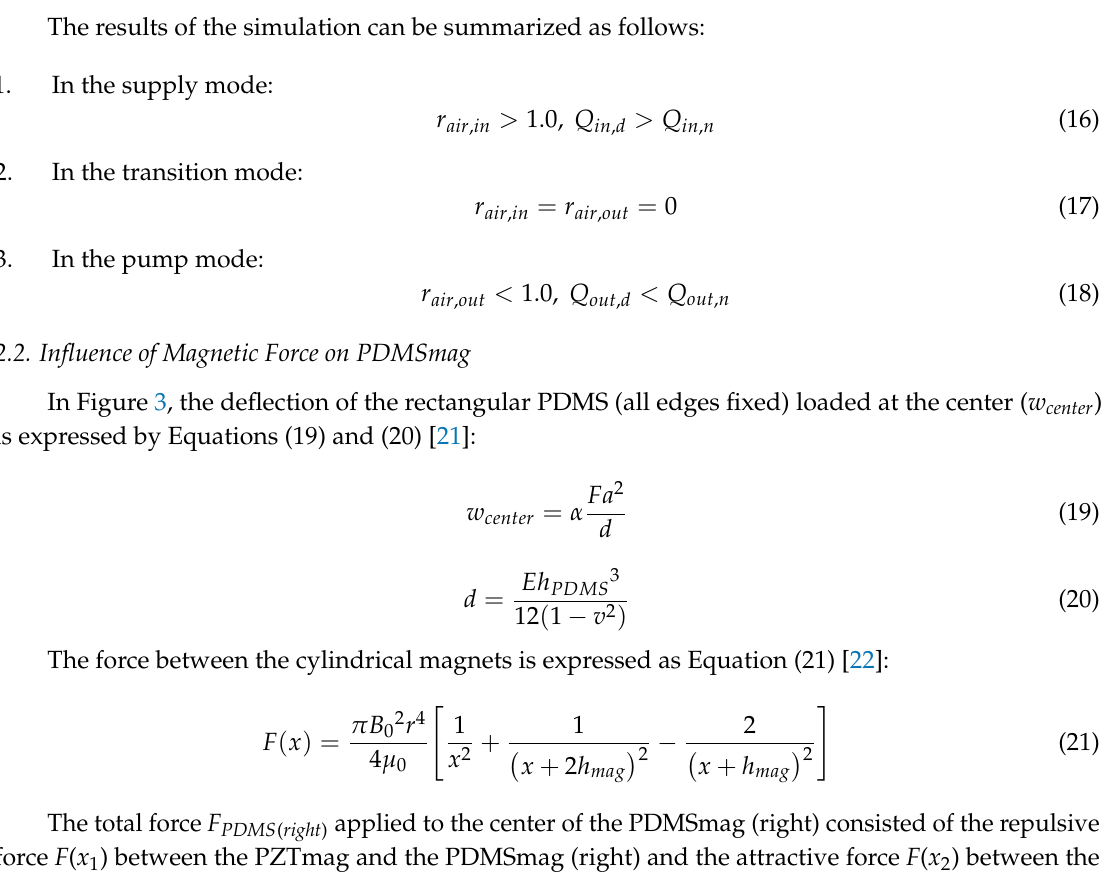
Figure 2. Ratio of air inflow and outflow at a channel opening width of 1 mm.